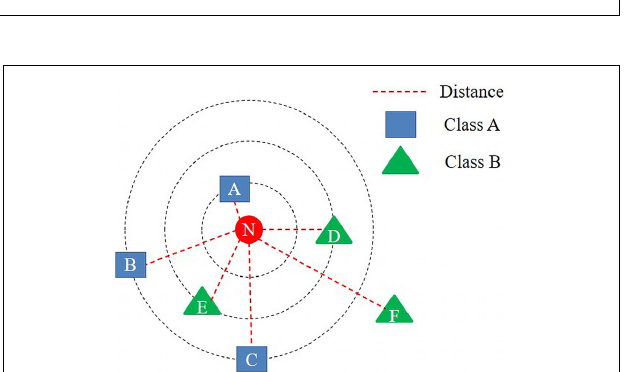
FIGURE 3 | The architecture of the pre-trained VGG16 (Ullah et al., 2020).